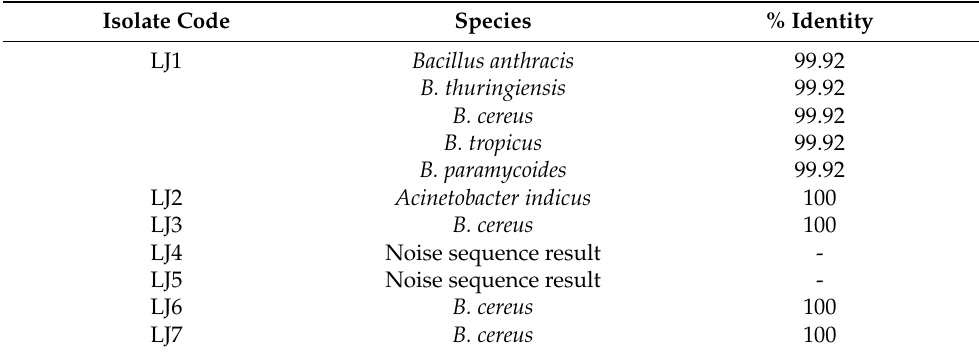
Table 2. Molecular identification of A. dorsata gut-associated bacterial isolates using 16S rRNA gene markers.